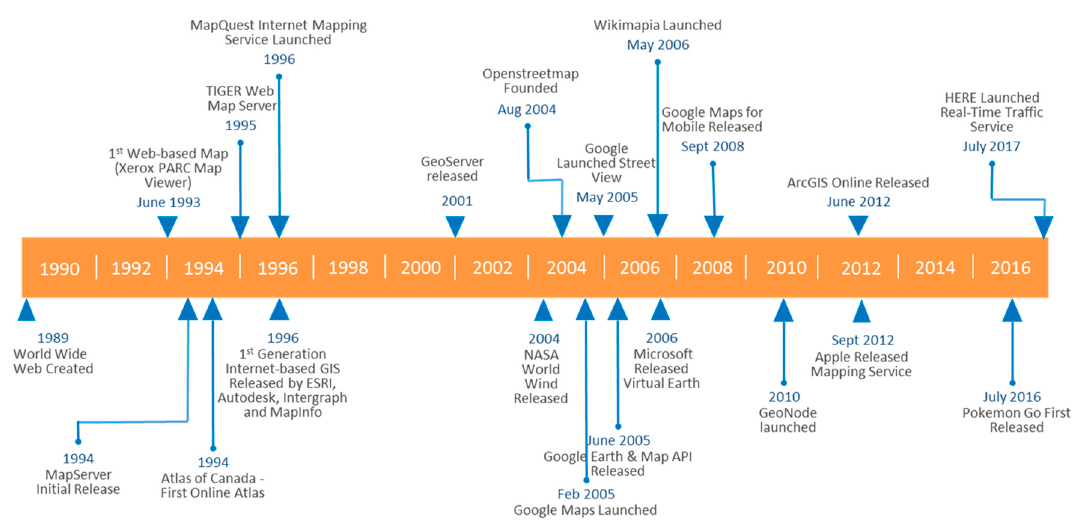
Figure 1. Timeline of some significant web mapping events.